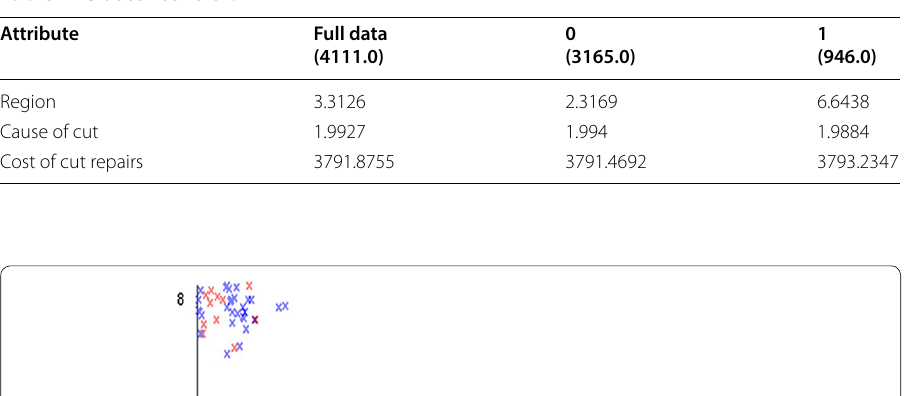
Table 4 Cluster centroid